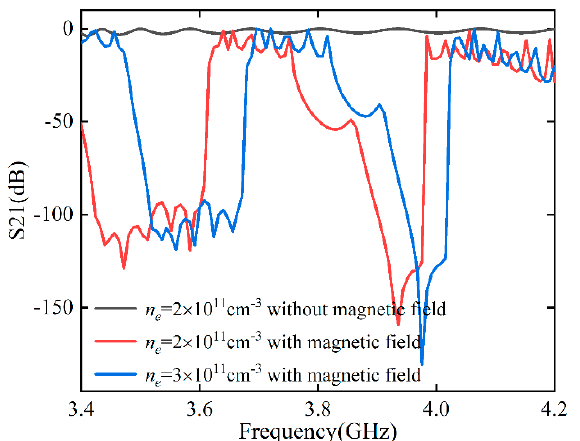
Figure 2. Transmission spectra of the PPC for different electron densities with or without magnetic fields when considering TM